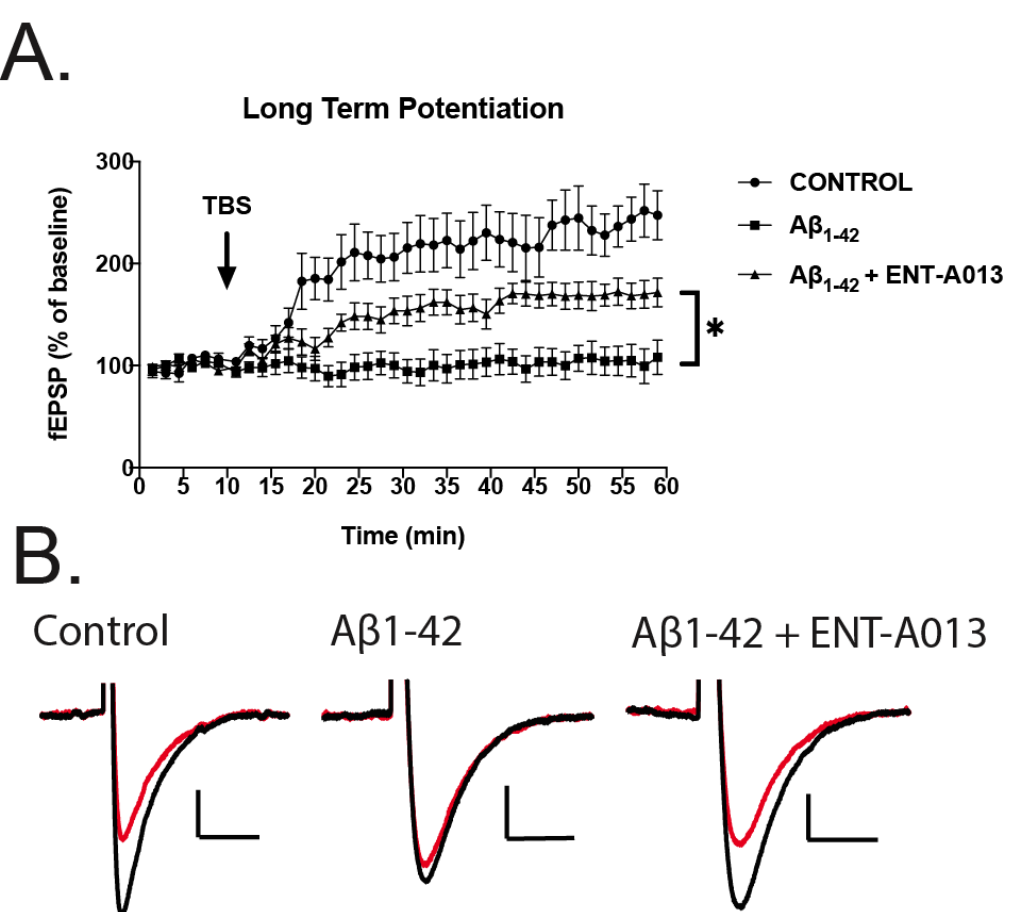
Figure 7. LTP in hippocampal brain slices treated with oligomeric Aβ (5 μ M) in the presence or absence of ENT-A013 (500 nM) for 3 – 5 h. ( A ) Graph showing LTP induced with TBS in control brain slices (i.e., no treatment, circles), in brain slices treated with oligomeric Aβ (5 μ M) and in brain slices treated with oligomeric Aβ (5 μ M) (squares) and ENT-A013 (500 nM) (triangles). Statistical analysis ANOVA shows that ENT-A013 treated brain slices have significantly higher synaptic potentiation compared to those treated only with Aβ. Error bars represent SEM. Mixed effects multiple comparison analysis. N = 7 – 9 slices from 3 – 4 animals. * p < 0.05 ( B ) Representative traces before (red) and after (black) theta-burst stimulation for the 3 different groups.